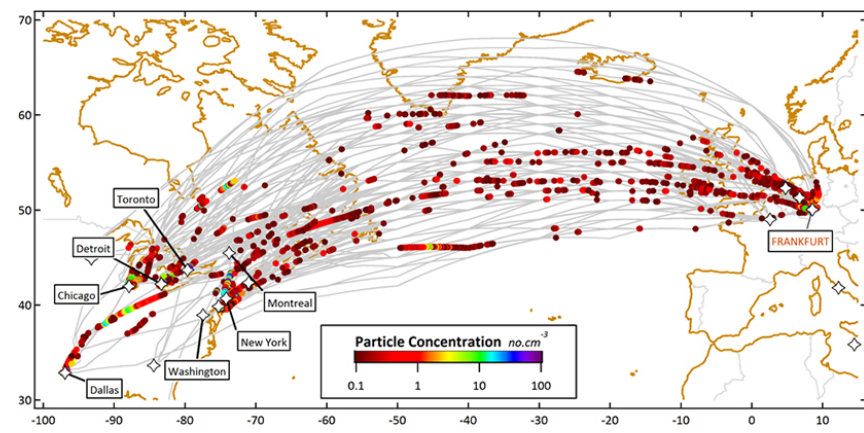
Figure 14. Similar to Fig. 13, but expanded to show only the flights between Europe and North America. Table 1. Cloud statistics from Airbus A340-300 BCP measurements. Number concentrations >0.01cm − 3 define a cloud. Fraction of flights Fraction of Fraction of Total Fraction of with cloud flights with flights with Total flight Total time flight hours encounters at cloud encounters cloud encounters Region flights hours in cloud in cloud (%) cruise altitude (%) at takeoff (%) at landing (%) Africa 85 453